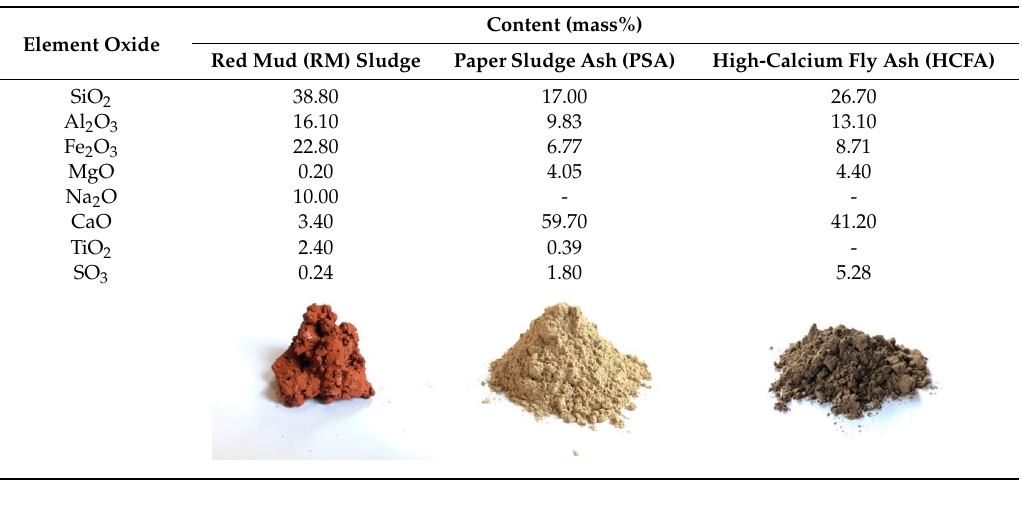
Table 1. Chemical composition of raw materials.